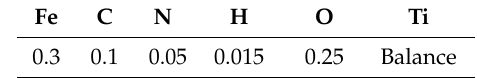
Table 2. Chemical compositions of commercial purity TA2 Ti Alloy sheets (wt %).